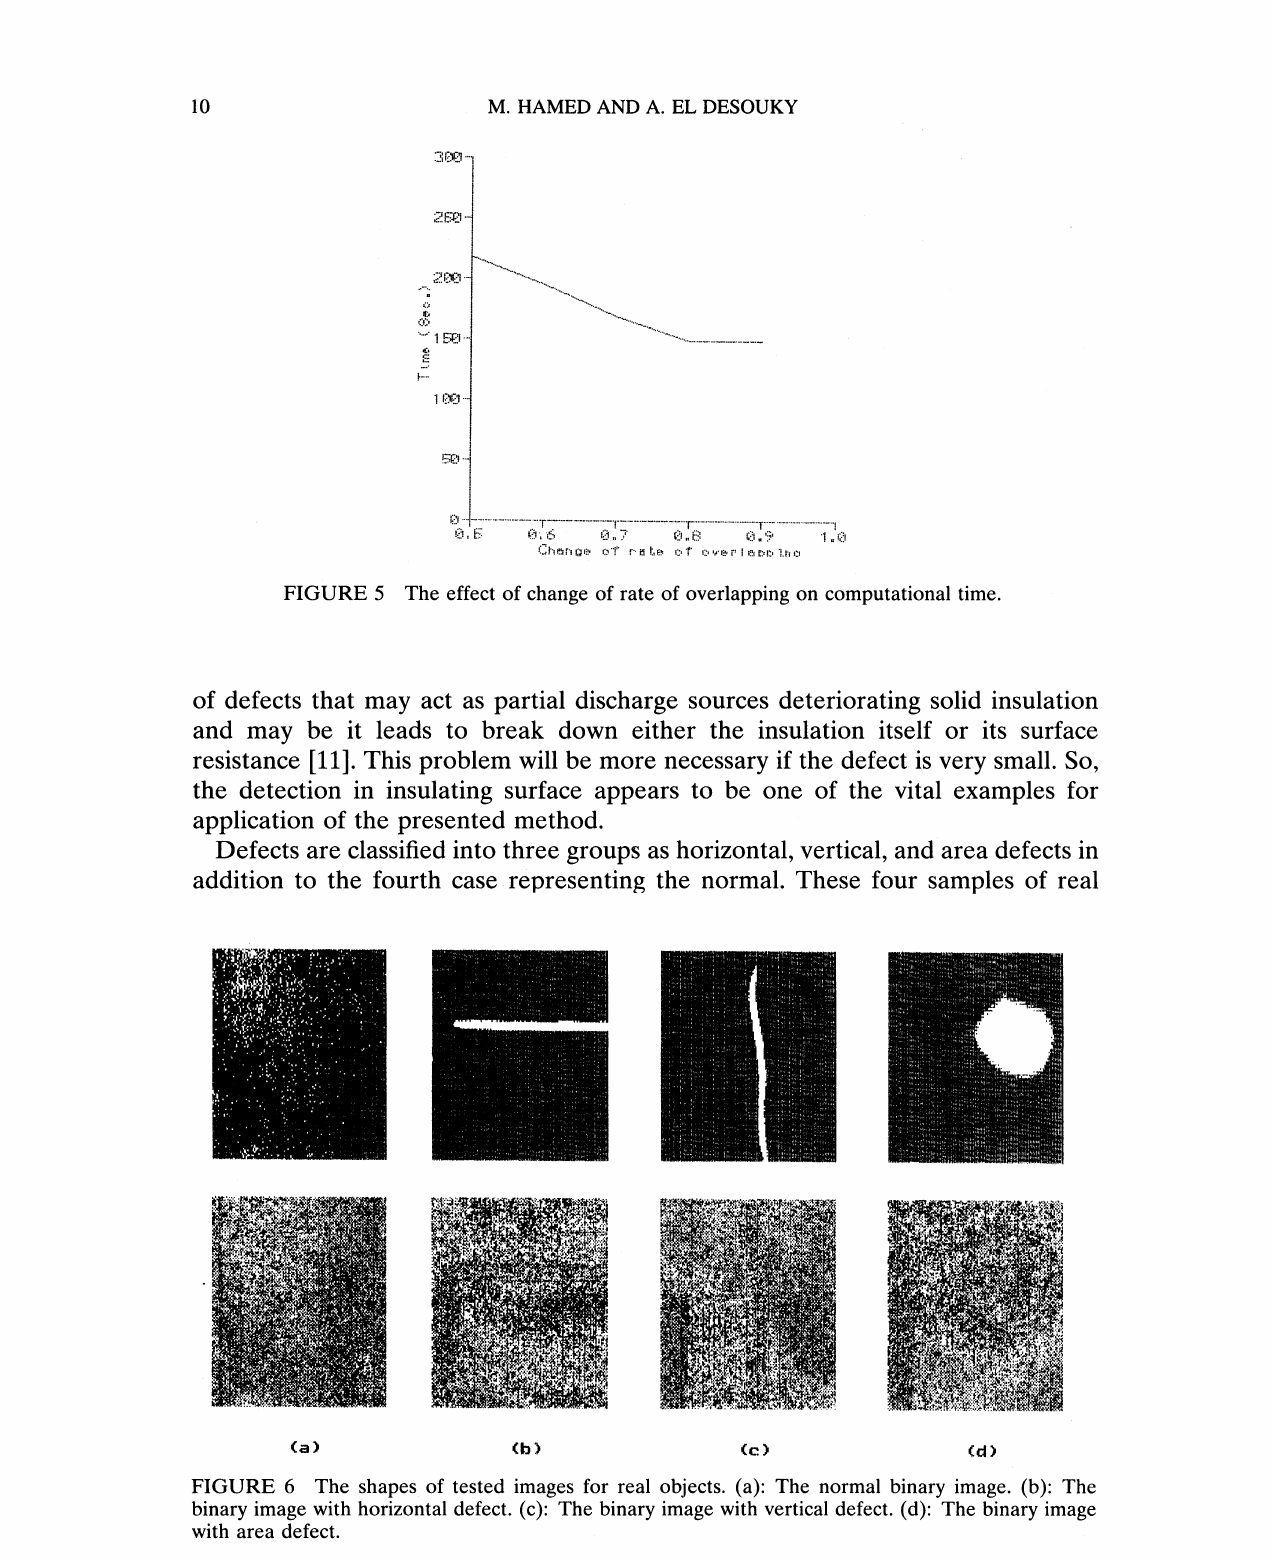
FIGURE 6 The shapes of tested images for real objects. (a): The normal binary image. (b): The binary image with horizontal defect. (c): The binary image with vertical defect. (d): The binary image with area